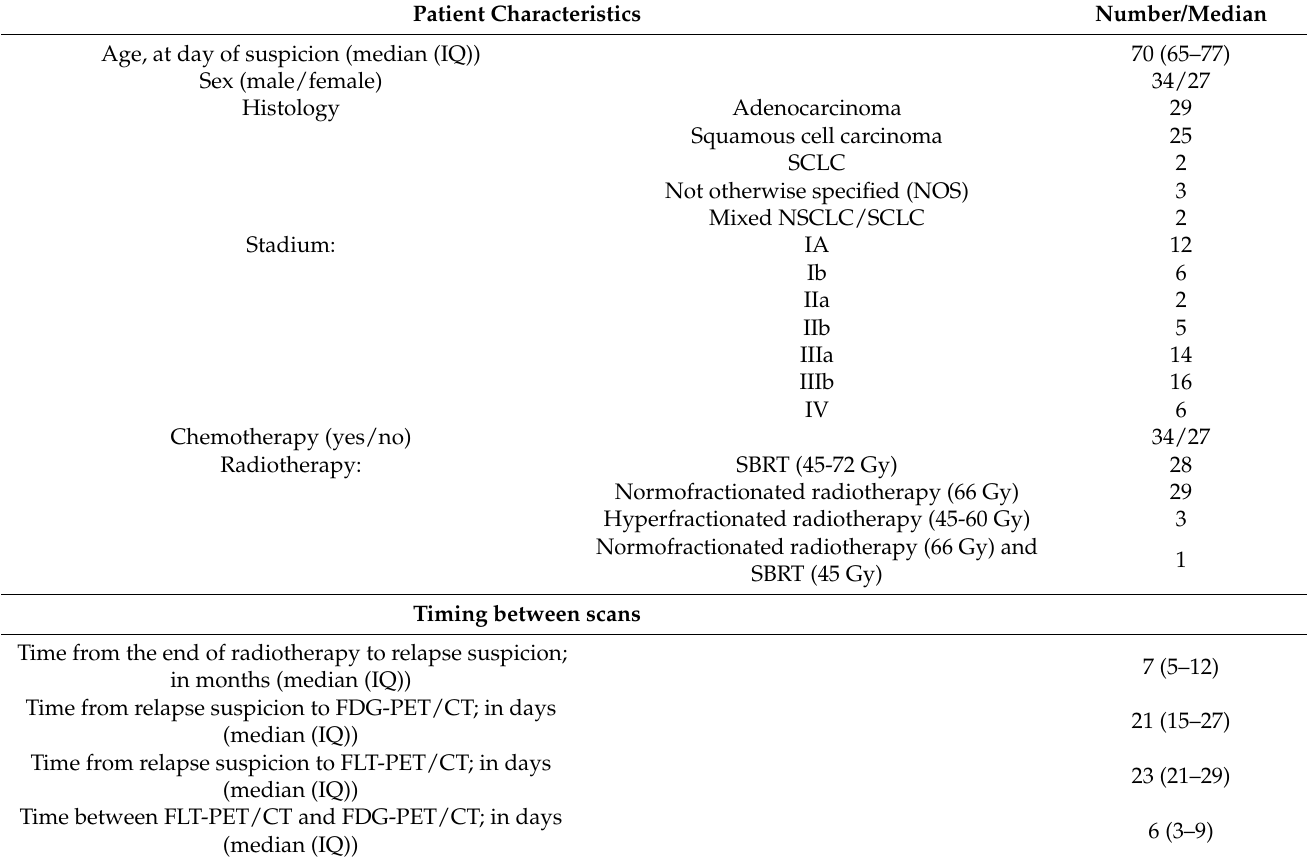
Table 1. Patient characteristics, time logistics, and outcome ( n =